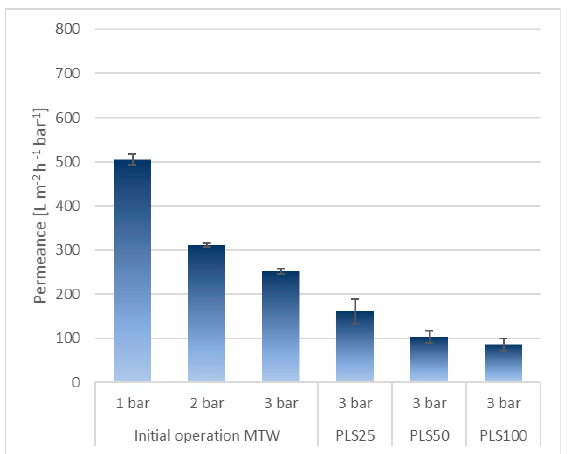
Figure 7. Initial operation permeance for MF at 1–2–3 bar with MTW, PLS25, PLS50, and PLS100 at 3 bar, 12 °C.